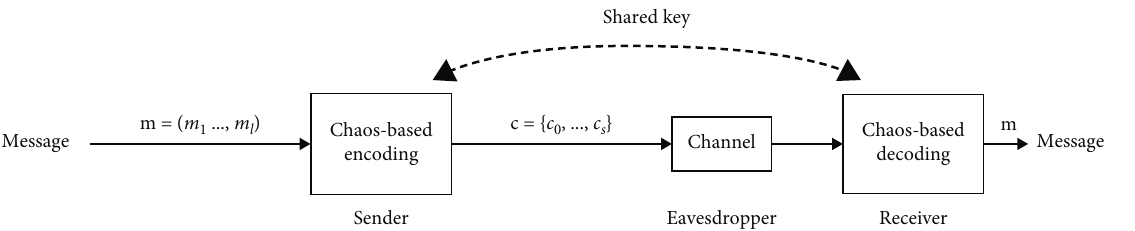
Figure 8: Model of secure data transmission scheme.